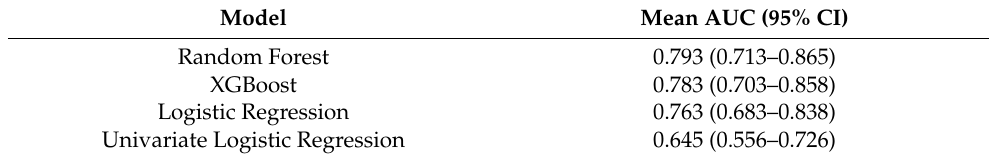
Table 3. Model performances for predicting lymph node metastasis (NST criteria